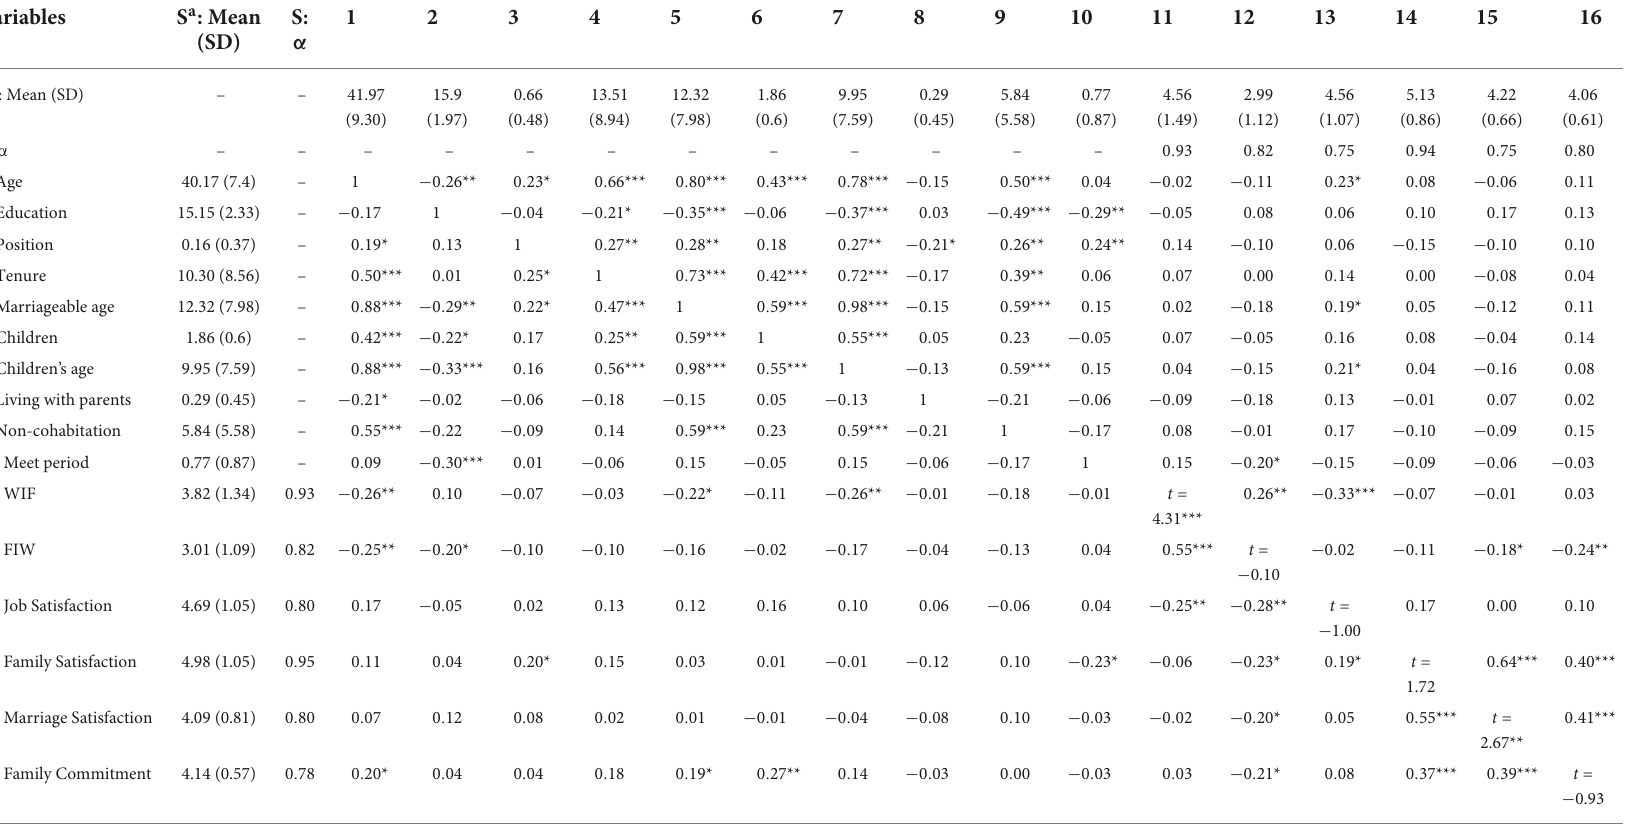
TABLE 1 Mean, standard deviation, Cronbach’s alpha coefficients, and inter-correlations for